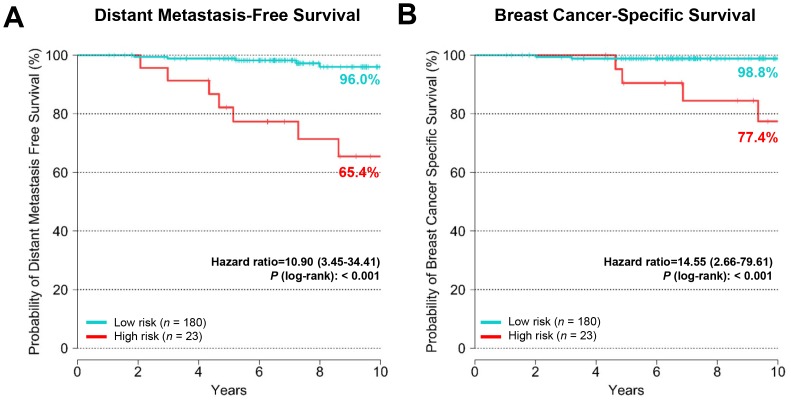
Kaplan-Meier plots for distant metastasis and breast cancer-specific death in patients with hormone therapy alone.(A) Distant metastasis-free survival and (B) breast cancer-specific survival in low-risk (n = 180) and high-risk (n = 23) groups stratified according to the BCT score. Patients with a BCT score <4 were classified as low risk, while those with a BCT score ≥4 were classified as high risk.